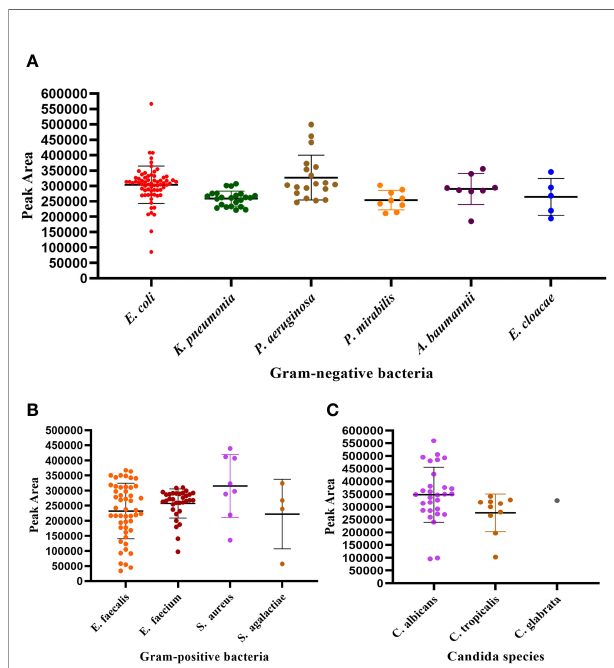
FIGURE 6 | The distribution of peaks for the 13 pathogens by UTI-HGS from the 266 clinical urine samples with monomicrobial infections. (A) Peak area distribution of 132 urine samples showing signi fi cant growth of one Gram- negative species of bacteria. (B) Peak area distribution of 94 urine sample showing signi fi cant growth of one species of Gram-positive bacteria. (C) Peak area distribution of 40 urine samples showing signi fi cant growth of one fungus. The peak area of 261 (98.12%) pathogens from clinical urine samples lay above the corresponding semi-quantitative UTI-HMGS-based cutoff